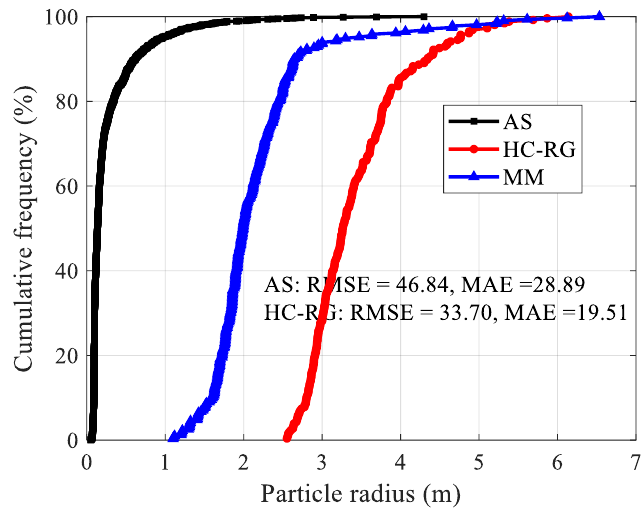
Figure 17. Particle radius distribution of lower accumulation of landslide.